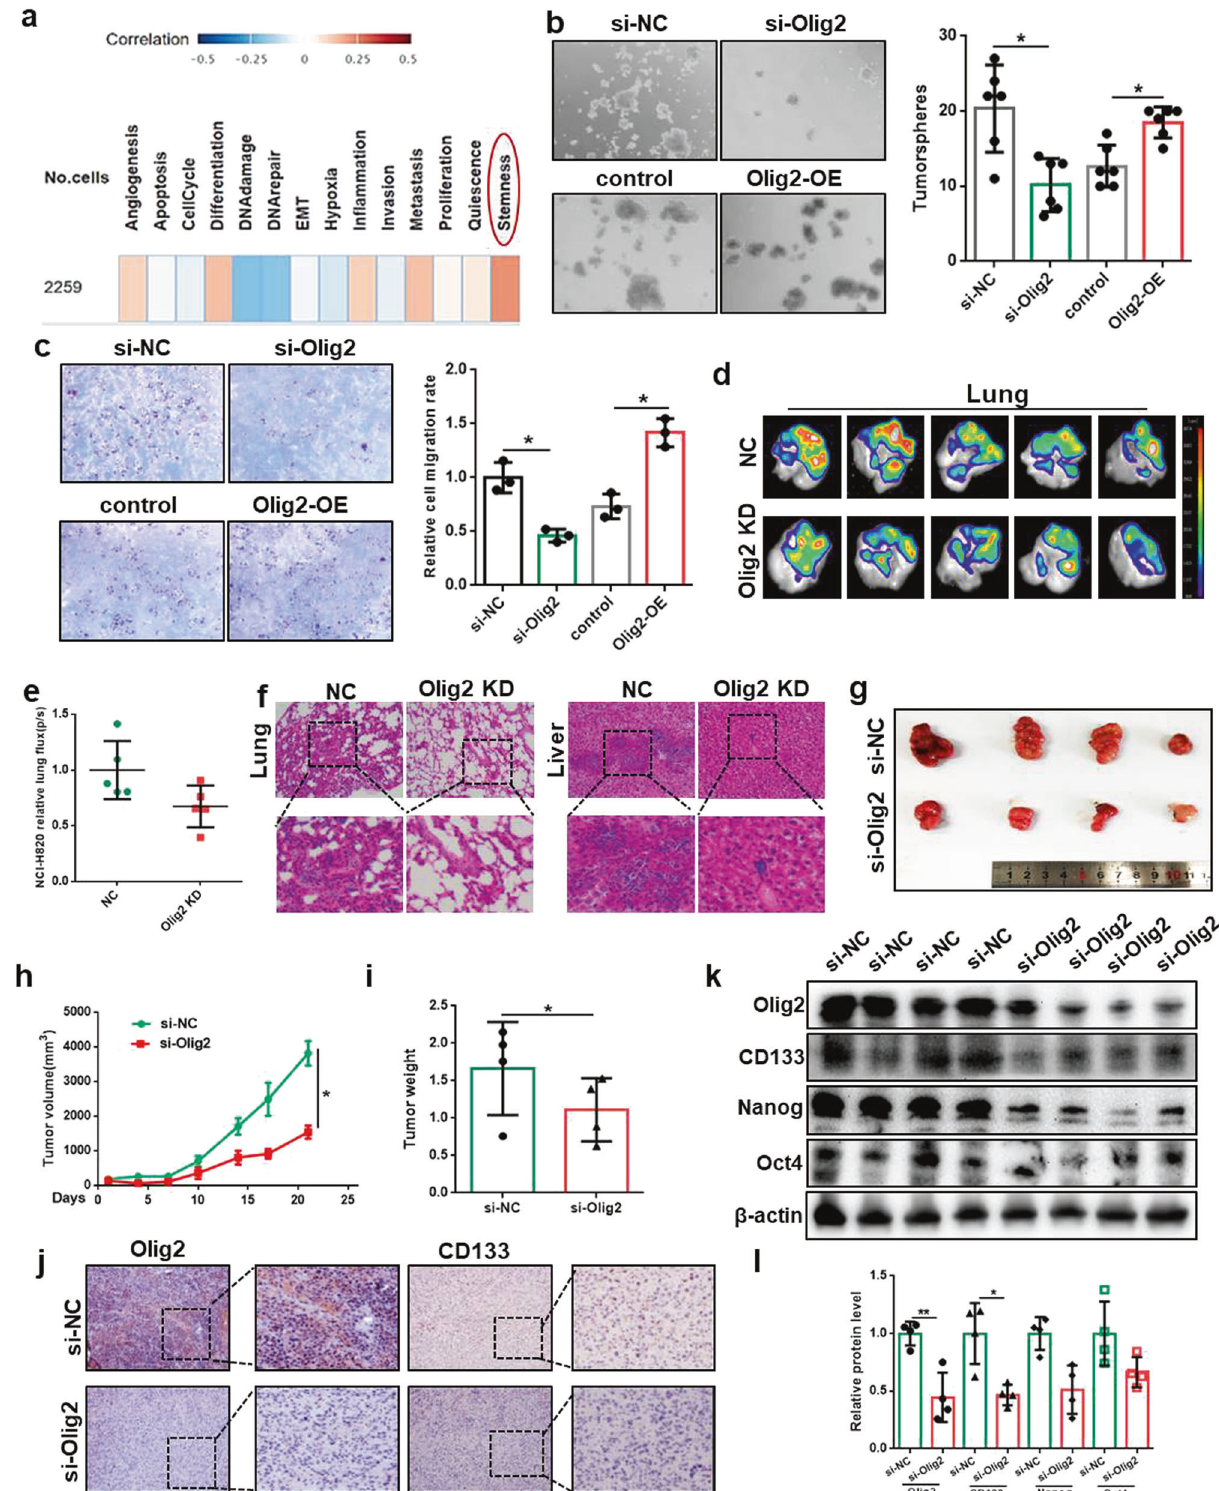
Olig2 promoted lung cancer cell stemness The functional states of Olig2 in glioma was analyzed by CancerSEA (http://biocc.hrbmu.edu.cn/CancerSEA/). As the result, Olig2 was signi fi cantly correlation with stemness in glioma (Fig. 2a). On the basis of this analysis, we wondered whether